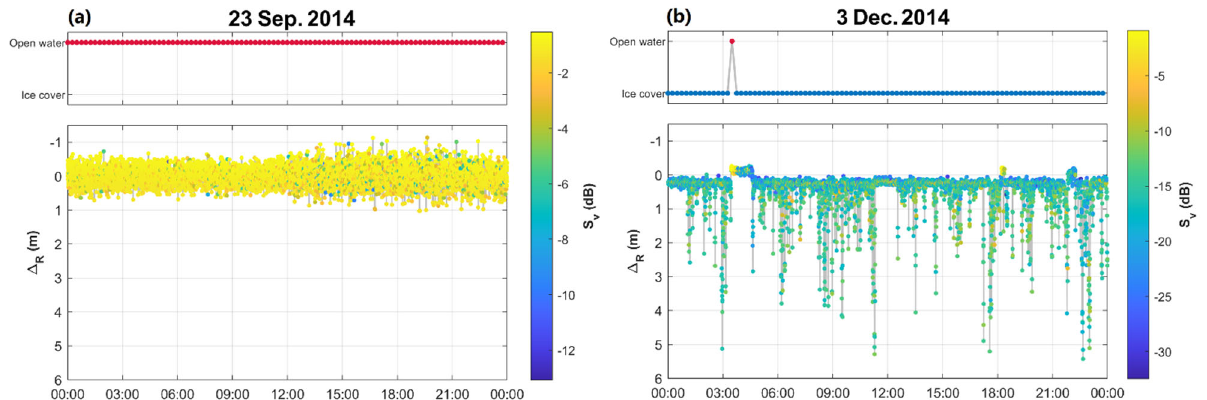
Figure 11. Plots of 𝛥 (cid:3019) (m) and SOM analysis for representative 24 ‐ h intervals, colored by 𝑆 (cid:3049) (dB). 𝛥 (cid:3019) from the AZFP dataset at the CEO site in the NE Chukchi Sea is shown for the open ‐ water inter ‐ val ( a ), and the ice ‐ covered interval ( b ). Above each plot of 𝛥 (cid:3019) is the SOM BMU for each ensemble, identifying it as either ice cover (blue) or open water (red).